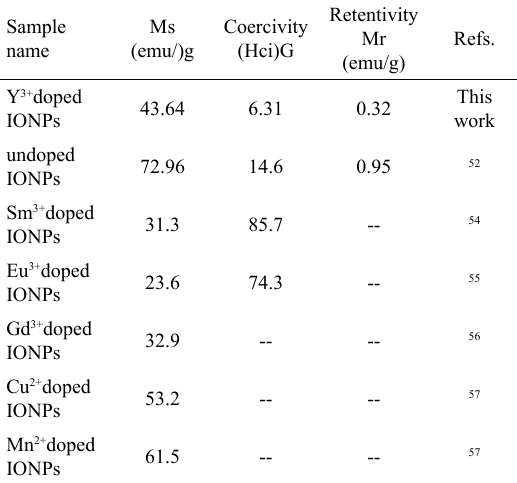
Table 1. Magnetic data of the undoped and doped iron oxide nanoparticles Sample